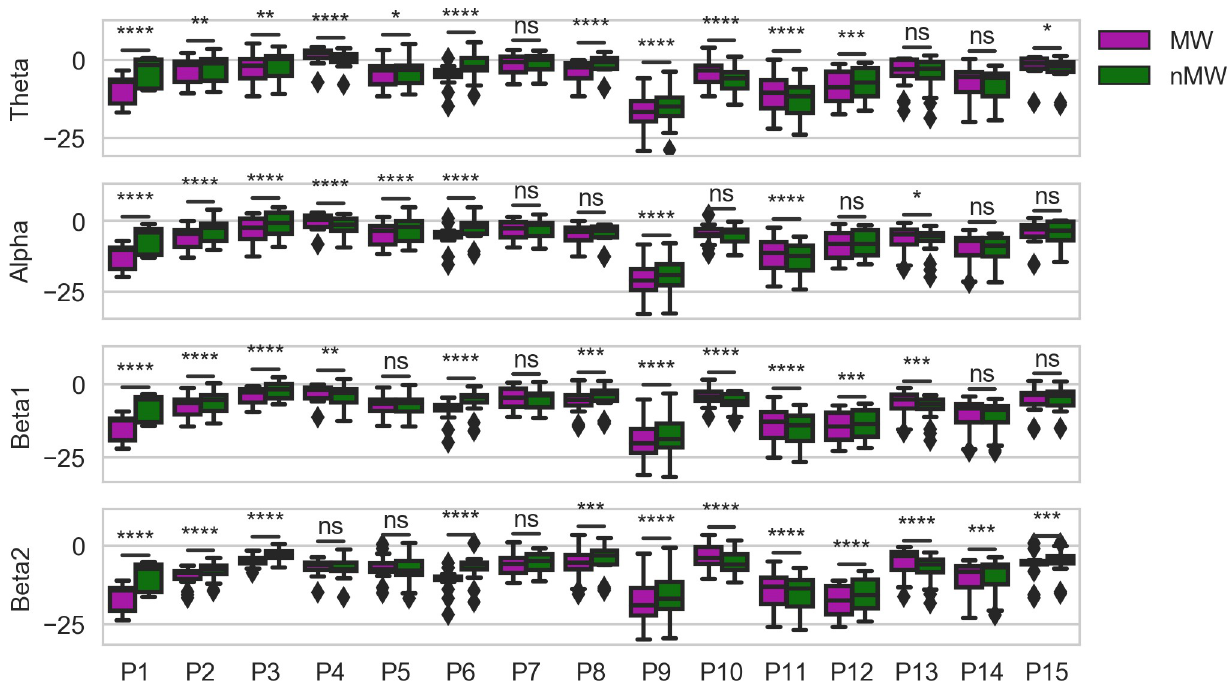
Fig 4. Power spectrum distributions for each participant in each frequency band, aggregated across channels. Statistical significance is calculated using paired-samples t-tests. Uncorrected p -values are reported as follows: � , p < 0.05, �� , p < 0.01, ��� , p < 0.001, ���� , p < 0.0001.